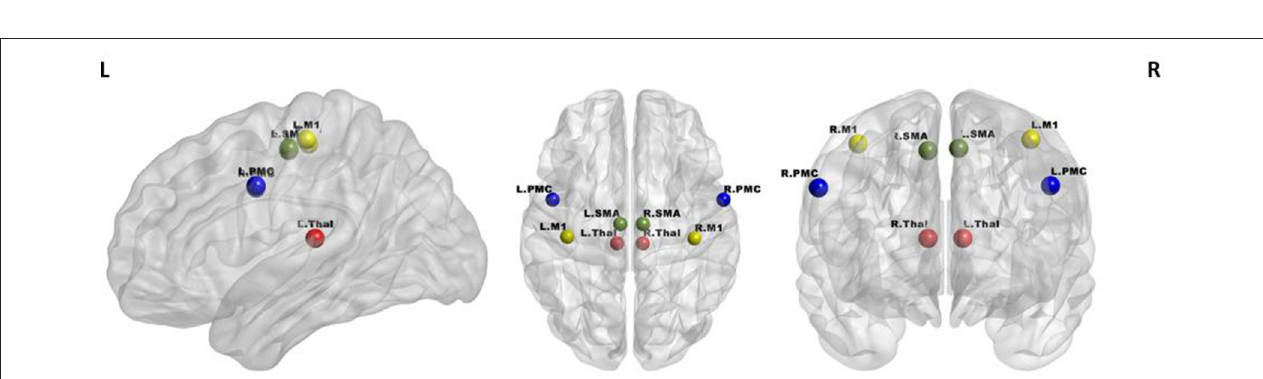
FIGURE 3 | Regions of interest in the motor network included four bilateral seeds: M1 (yellow), PMC (blue), SMA (green), and Thalamus (red).